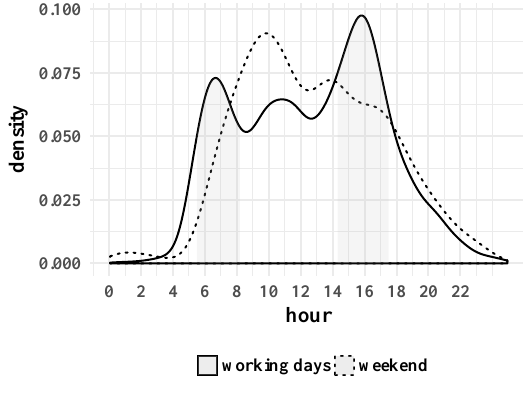
Figure 6. Density trip per hour of the